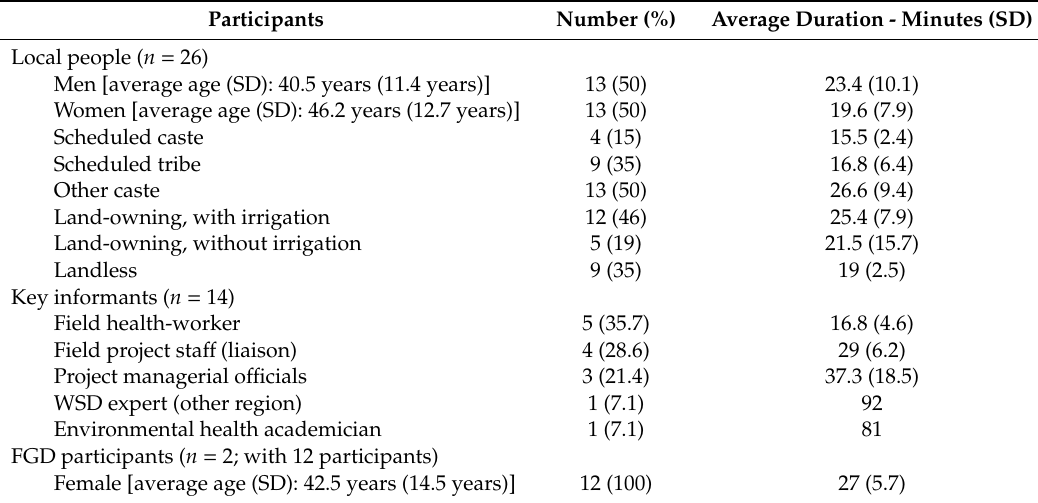
Table 3. Details of interviewed